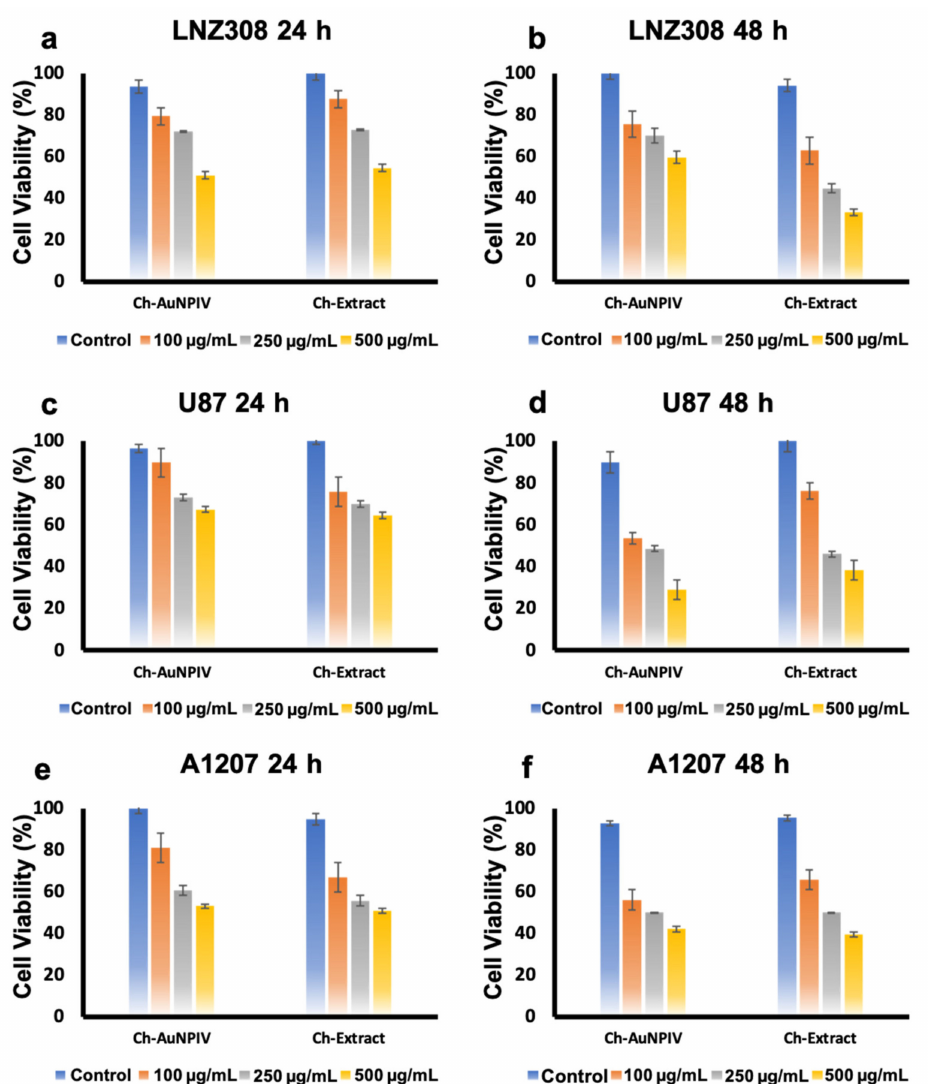
Figure 5. Cytocompatibility/toxicity analysis of the Ch-AuNPIV on brain cancer cell lines. Similar to that of normal cell lines, it could be observed that the NPs exert toxicity to the cells ( a , c , e ), which gets more pronounced with increase in incubation time ( b , d , f